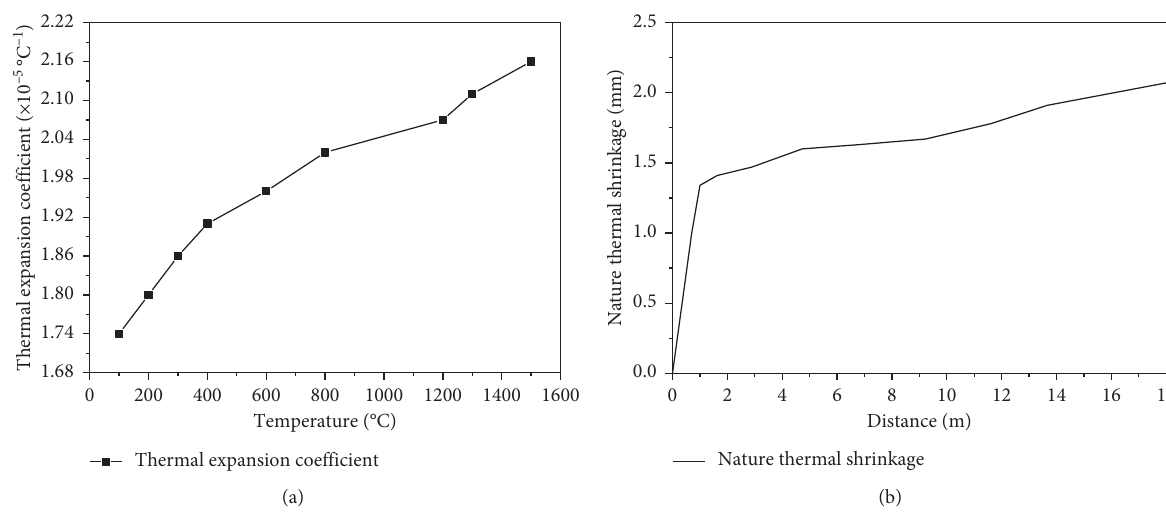
Figure 3: Solidification characteristics of nuclear power stainless steel. (a) Thermal expansion coefficient. (b) Nature thermal